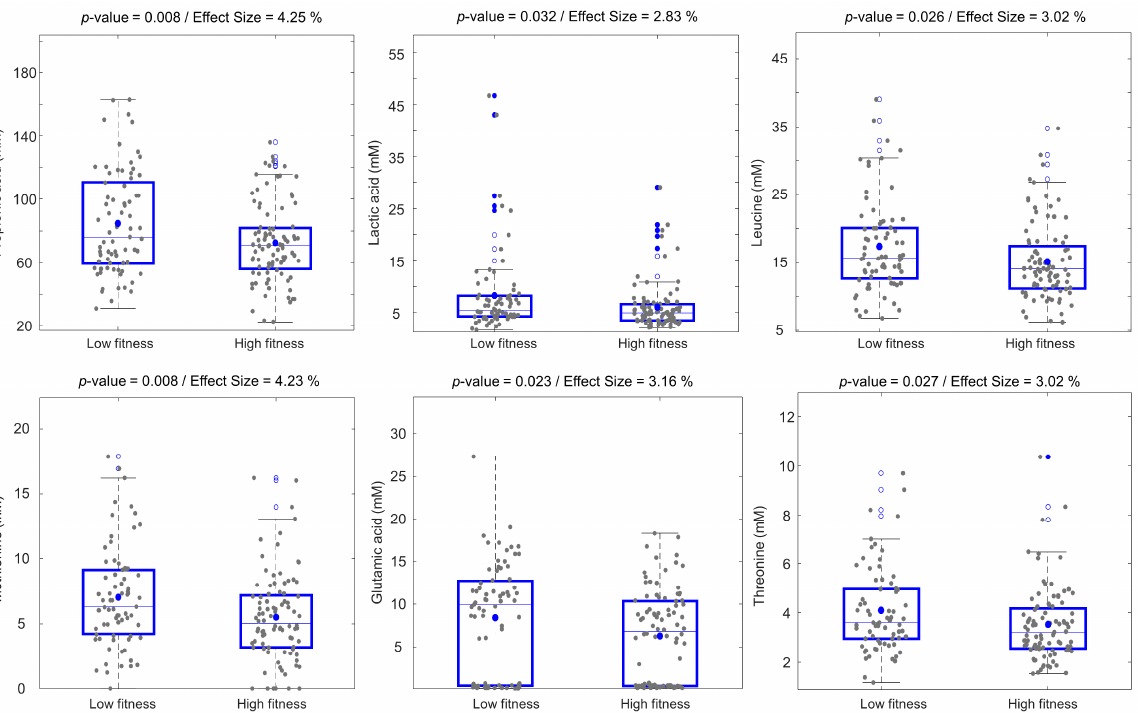
Figure 2. Boxplots of selected human fecal metabolites detected using 1 H NMR spectroscopy that are found to be different between low- and high-fitness subjects (low fitness, n = 73; high fitness, n = 90). p -values and effect sizes (%) are calculated from ANOVA. The horizontal lines and dots inside the boxes represent median and mean values, respectively. Blue circles and blue-filled circles correspond to quartiles >75% and 95%, respectively.